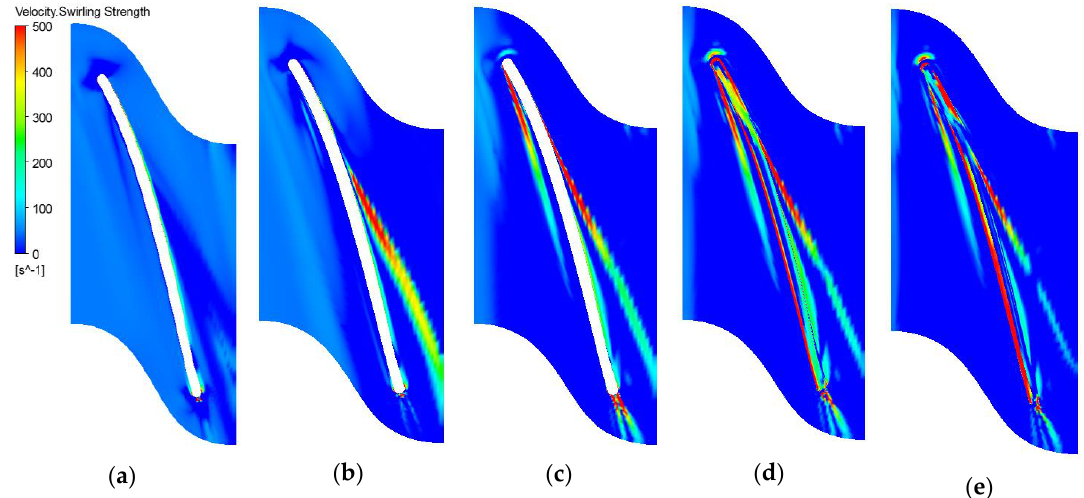
Figure 9. Swirling intensity on di ff erent circumferential sections ( δ = 0.5%, designed Q). Span ( a ) 0.9, ( b ) 0.95, ( c ) 0.98, ( d ) 0.985, and ( e ) 0.99.